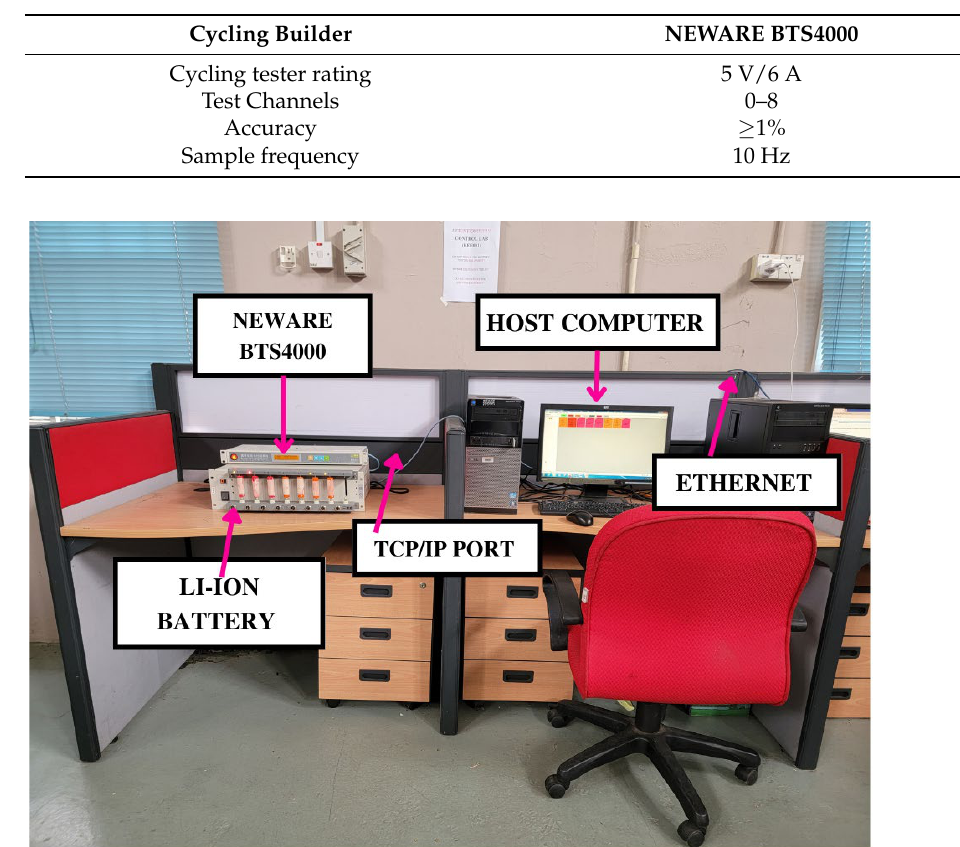
Figure 4. Test bench for battery cell testing comprising a host computer, Neware (BTS4000), TCP/IP PORT, an air conditioner, and the internet.